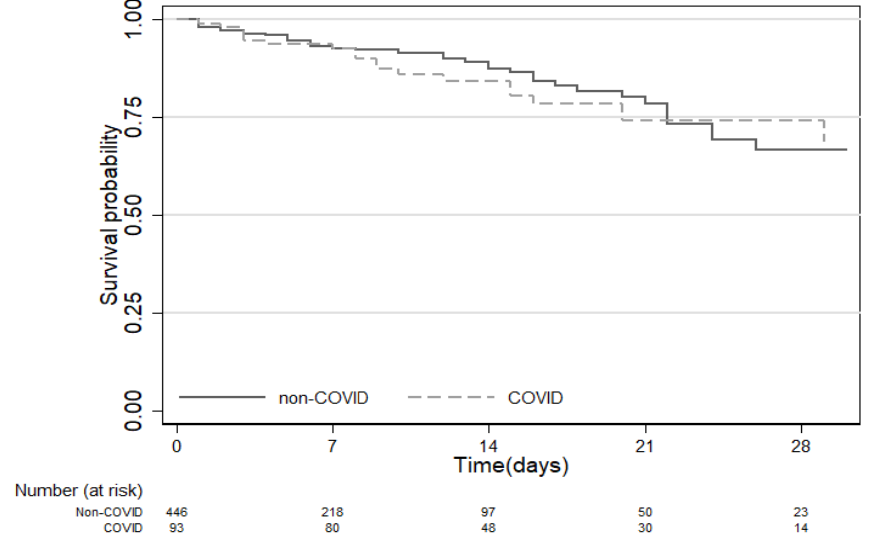
Figure 3. Figure 3. Kaplan – Meier curve comparing 28-day mortality of COVID-19 and non-COVID-19 ICU patients.